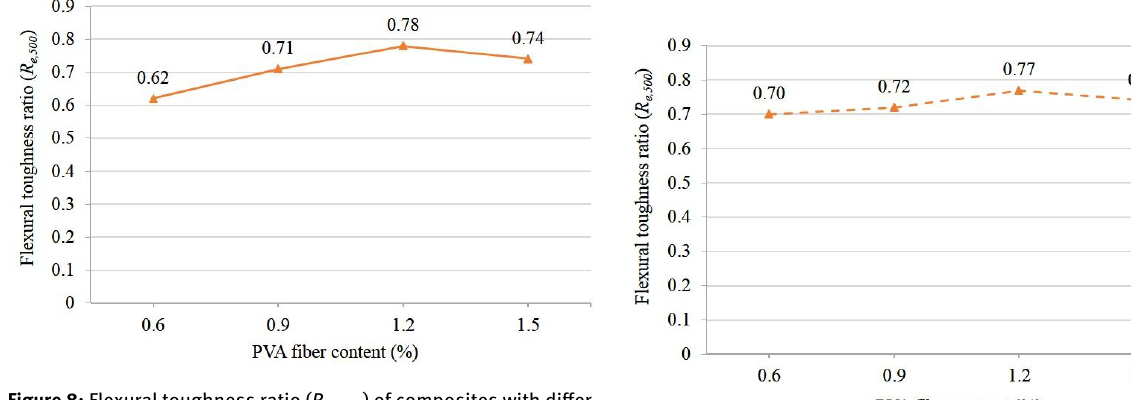
Figure 8: Flexural toughness ratio ( R e ,500 ) of composites with differ-